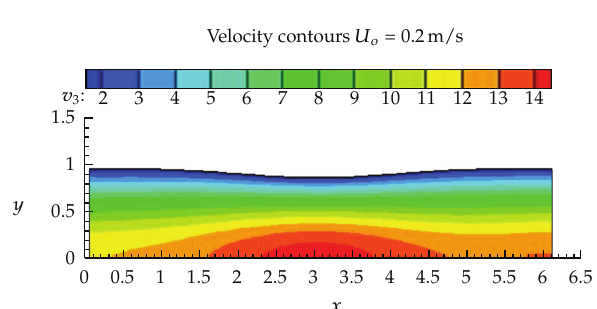
Figure 4: Typical velocity profile at time t (cid:7) 0 . 1 shows that the flow is fully developed throughout the